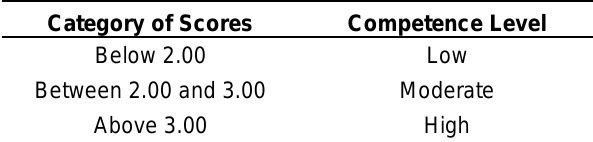
Table 3. Alpha Coefficients Value of